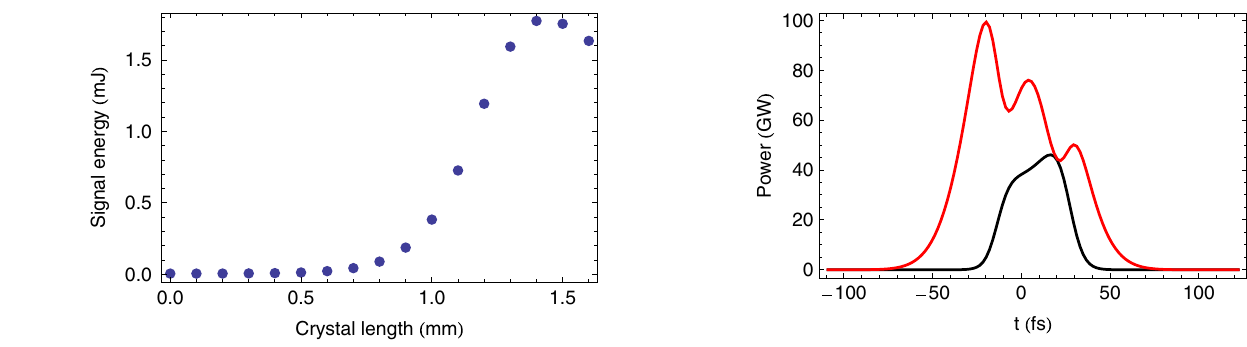
FIG. 8. Calculated amplified 2 (cid:1) m pulse energy as a function of crystal length of the second optical parametric amplifier. The input pump energies of the signal and pump are 1 (cid:1) m and 10 mJ, respectively, pulses have transform-limited 50 fs FWHM duration, and the beams are fourth-order super- Gaussian with 1 =e 2 full width of 10